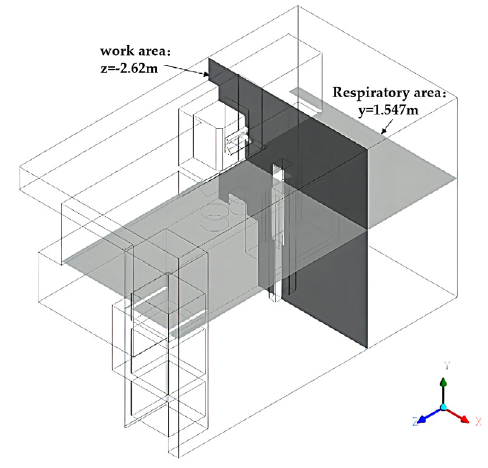
Figure 10. Cross section at y = 1.547 m with z = − 2.62 m .